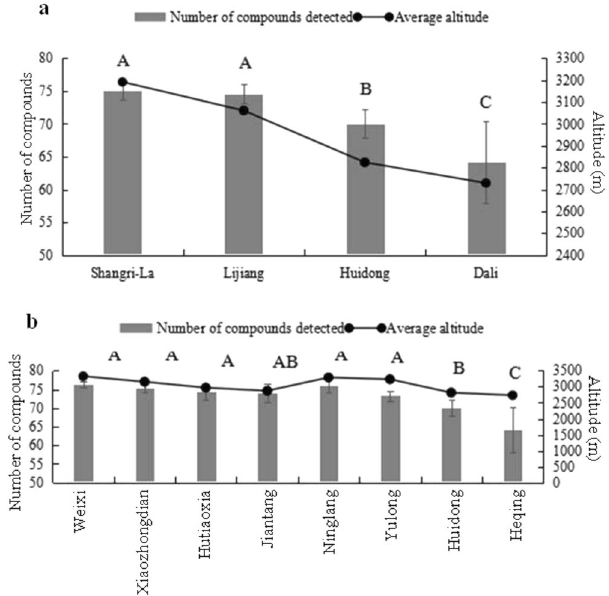
Figure 4. Number of compounds detected in Maca samples of different altitudes. ( a ) Different cities. ( b ) Different towns.